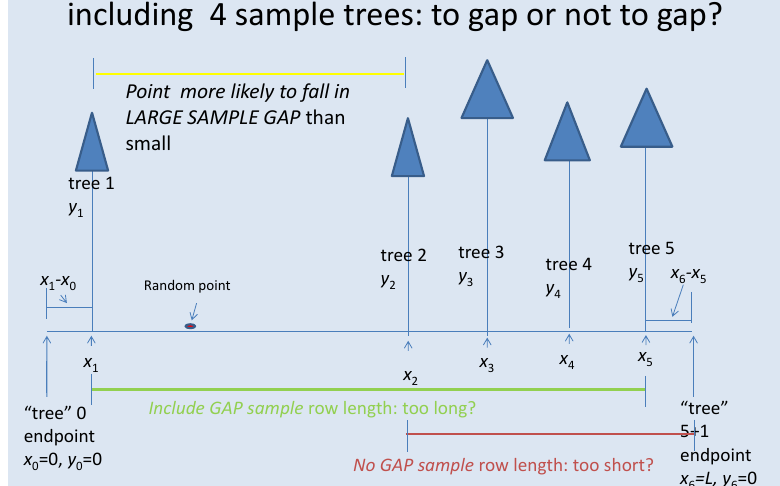
Figure 3. Illustration of the trade-offs for ratio estimators (Equations (10)–(12) and (17)) between selecting a sample row segment that does or does not include the gap between trees on a row into which a randomly located point, z ,